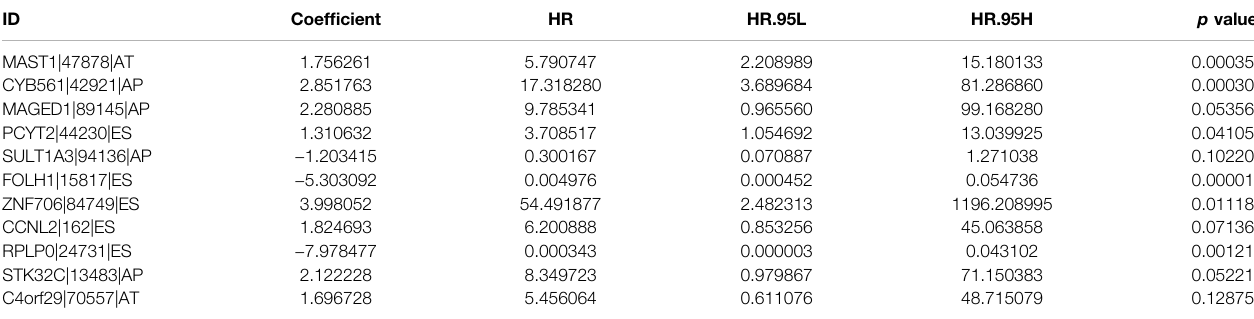
TABLE 2 | Eleven AS events associated with the OS of UCEC